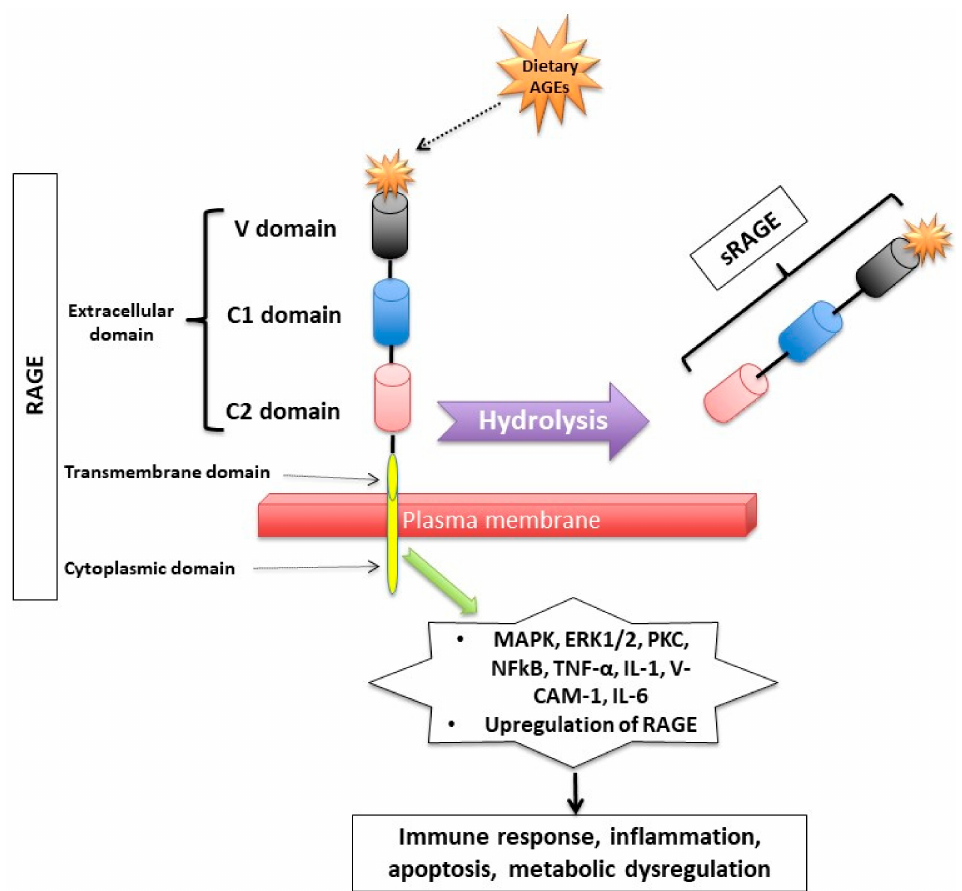
Figure 2. Receptor for Advanced Glycation End (RAGE) products and its mechanism of action. RAGE consists of transmembrane, cytosolic and extracellular domains. The extracellular domain consists of V, C1, and C2 domains. The soluble fragment of RAGE (sRAGE) is produced by hydrolysis of the RAGE receptor and contains the RAGE’s extracellular domain only. The binding of AGEs to RAGE induces a series of inflammatory and apoptotic responses intracellularly and contributes to metabolic dysfunction [32–34,44–49]. Mitogen-activated protein kinase (MAPK), extracellular signal-regulated kinase1/2 (ERK1/2), protein kinase C (PKC) and nuclear factor kappa B (NF- κ B), lysyl oxidase (LOX), tumor necrosis factor (TNF- α ), interleukin-1 (IL-1), vascular adhesion molecule-1 (VCAM-1), and interleukin-6